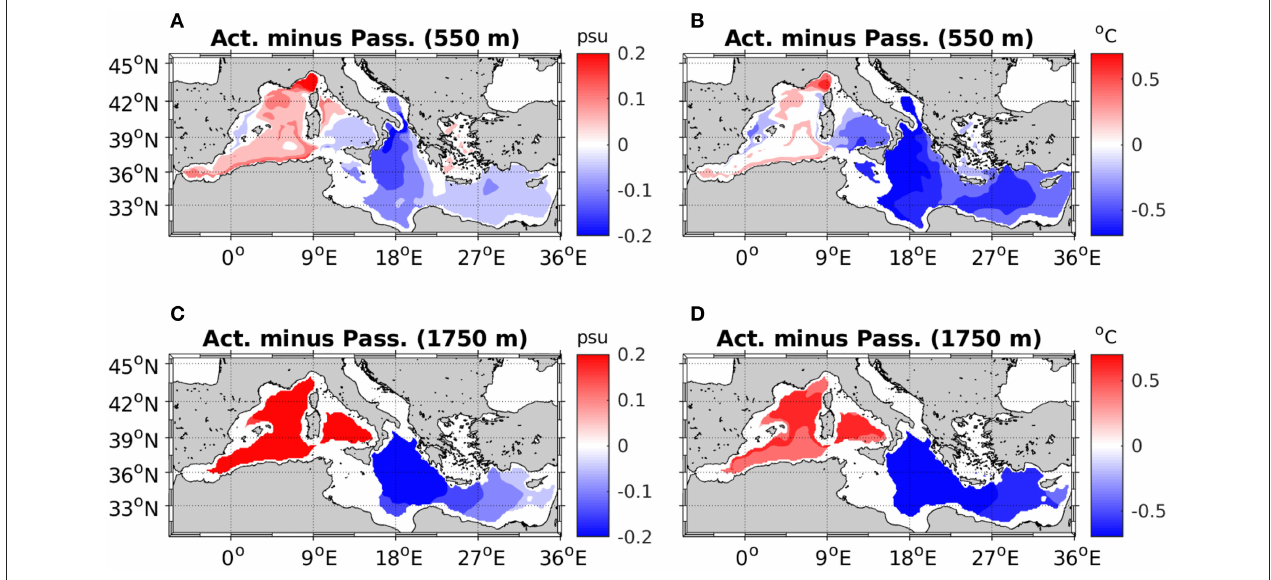
FIGURE 5 | Active and passive Adriatic states’ differences in salinity and temperature, at depths of 550 m (A,B) and 1,750 m (C,D) .